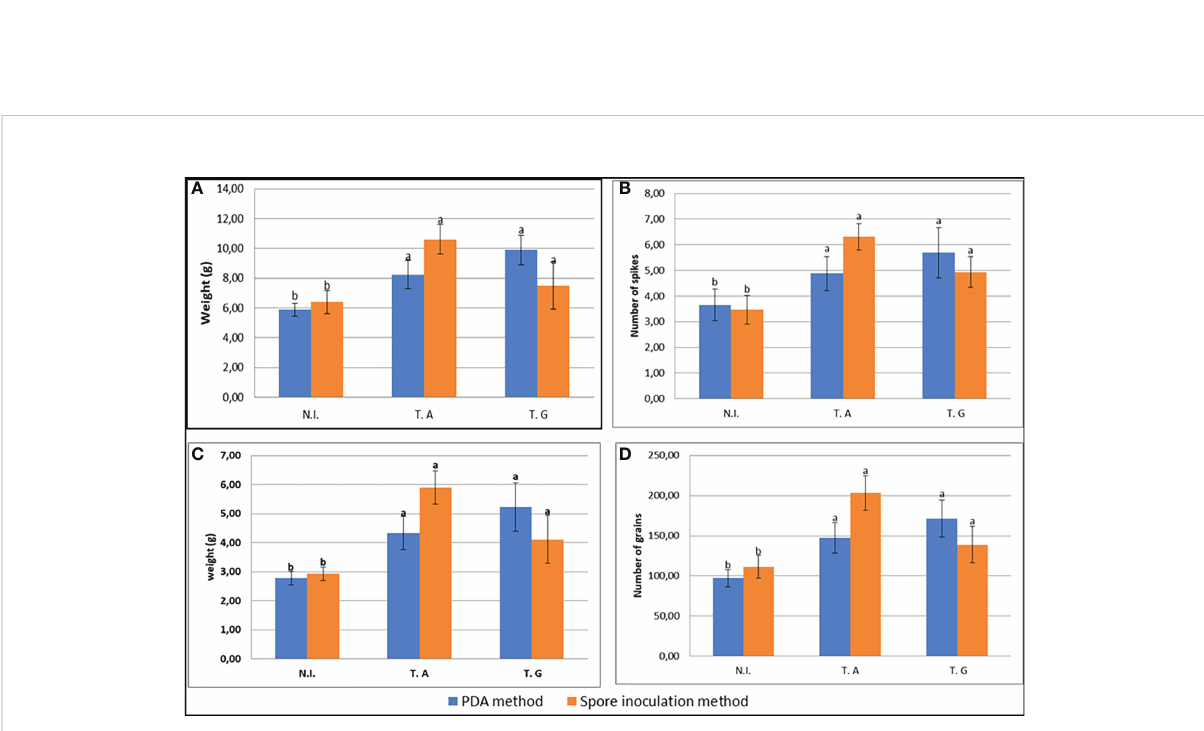
FIGURE 5 Yield parameters: (A) Total dry plant weight (g)/plant; (B) Number of spikes/plant; (C) Total grains weight (g)/plant; (D) Number of grains/plant, as in fl uenced by PDA and spore inoculation methods. N.I.: T.A: wheat plants inoculated with T. afroharzianum ; T.G: wheat plants inoculated with T. guizhouense Values in the same graph having different letters are signi fi cantly different, at P ≤ 0.01 (ANOVA test). 32 plants were analyzed per